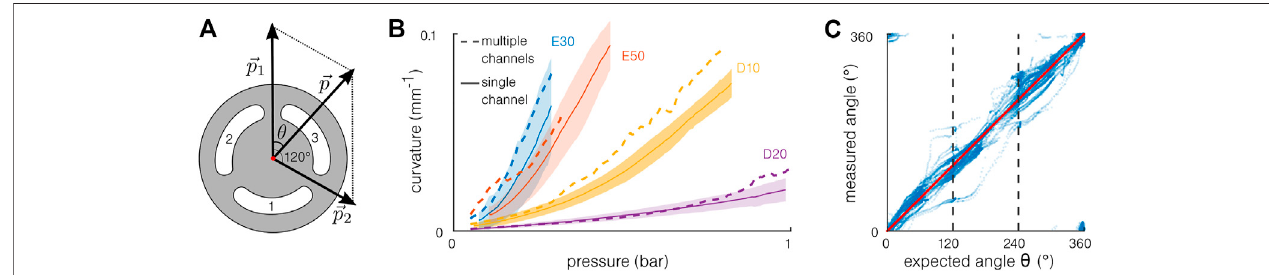
FIGURE8| Multi-channelactuation. (A) Modelformulti-channelactuation:thepressures (cid:2) p 1 and (cid:2) p 2 resultinapressure (cid:2) p havinganangle θ . (B) Experimentalresults of curvature in multi-channel actuation using the computed combined pressure and compared to those of the single-channel actuation. The model underestimates the pressure required to reach a given angle in multi-channel actuation. (C) The bending direction follows the model and the expected angle θ in multi-channel actuation, despite some large variations.